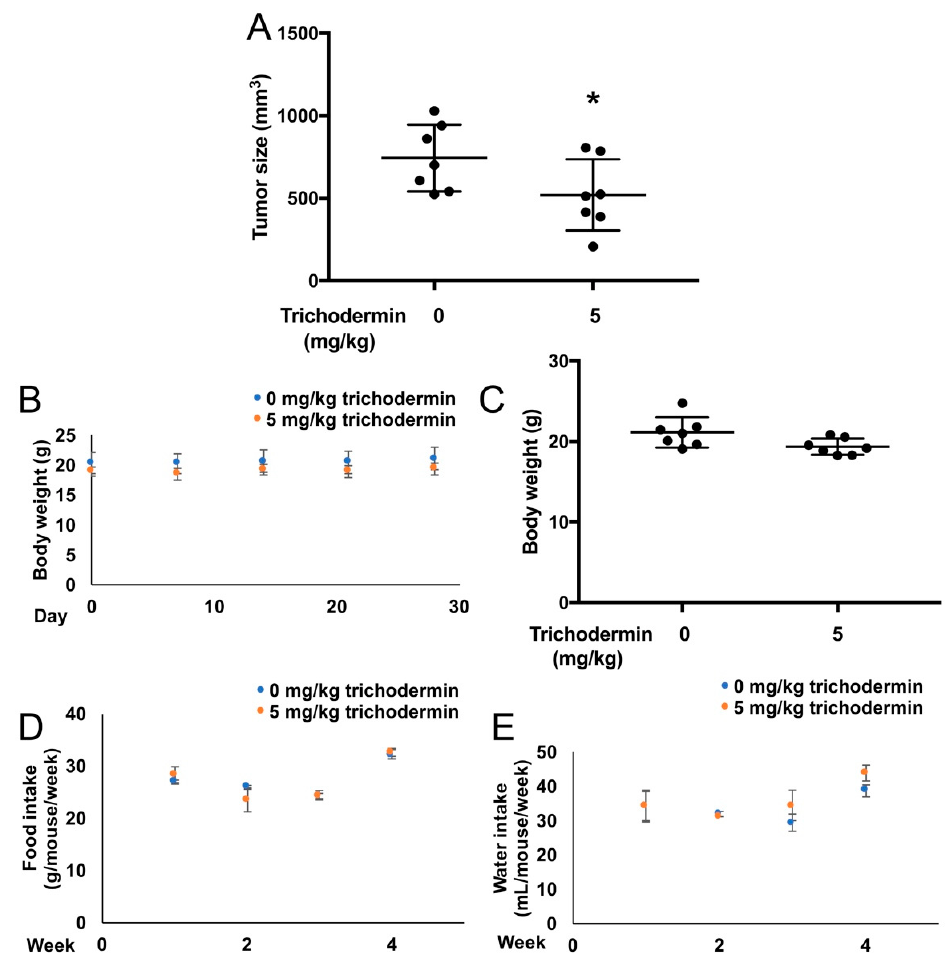
Figure 6. Trichodermin inhibited the growth of OVCAR-3 xenografts in BALB/C nude mice. OVCAR-3 human ovarian cancer cell suspension (containing 5 × 10 6 cells) was mixed with Matrigel (1:1, v / v ) and implanted subcutaneously between the scapula of nude mice. After palpable tumors were formed (tumor size > 30–60 mm 3 ), mice were injected three times weekly with 0.2 mL vehicle (sterile PBS) or trichodermin (5 mg/kg body weight, dissolved in pre-warmed sterile PBS) for four weeks. ( A ) Tumor size at Day 28 of trichodermin (5 mg/kg body weight) or vehicle treatment. ( B ) Body weight during the four-week treatment of trichodermin (5 mg/kg body weight) or vehicle. ( C ) Body weight at Day 28 of trichodermin (5 mg/kg body weight) or vehicle treatment. ( D ) Food intake and ( E ) water intake during the four-week treatment of trichodermin (5 mg/kg body weight) or vehicle. * p < 0.05 compared with the control group.